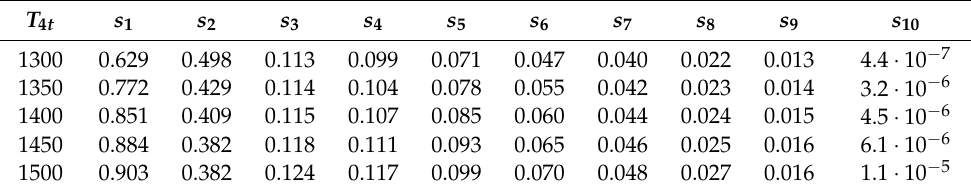
Table 6. Singular values of the Jacobians of the sensors with respect to the degradations at zero degradations, J x ( T 4 t , 0 ) , for the indicated values of T 4 t .